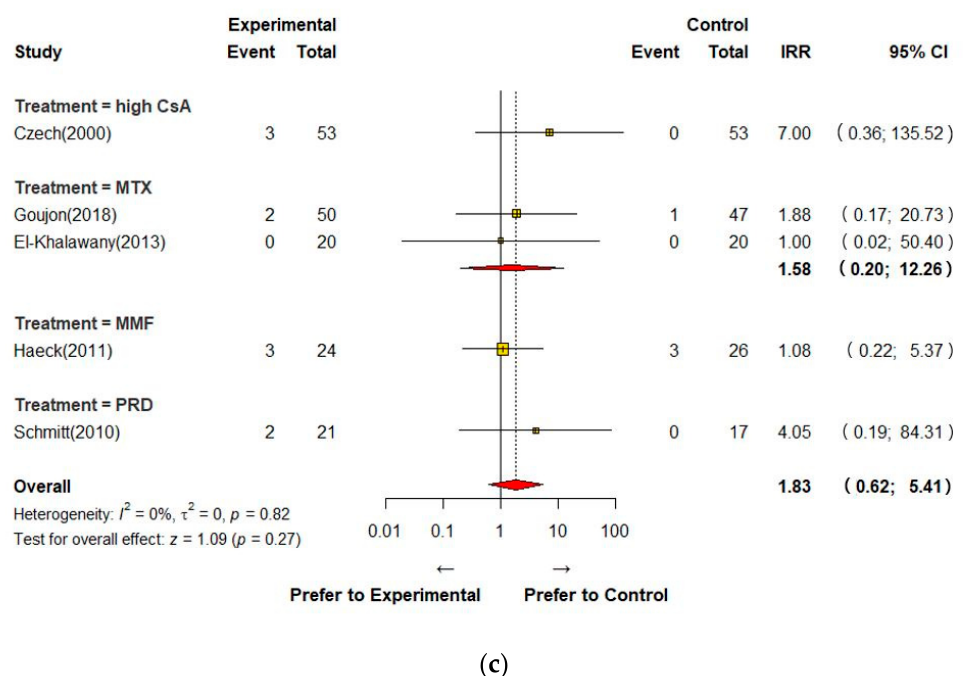
Figure 4. Meta-analysis of the adverse events ( a ), the adverse events excluding Heack’s study ( b ), and the serious adverse events ( c ) [13–17]. CI; confidence interval, CsA; Cyclosporine A, IRR; incidence relative risk, MMF; mycophenolate mofetil, MTX; methotrexate, PRD; prednisolone.